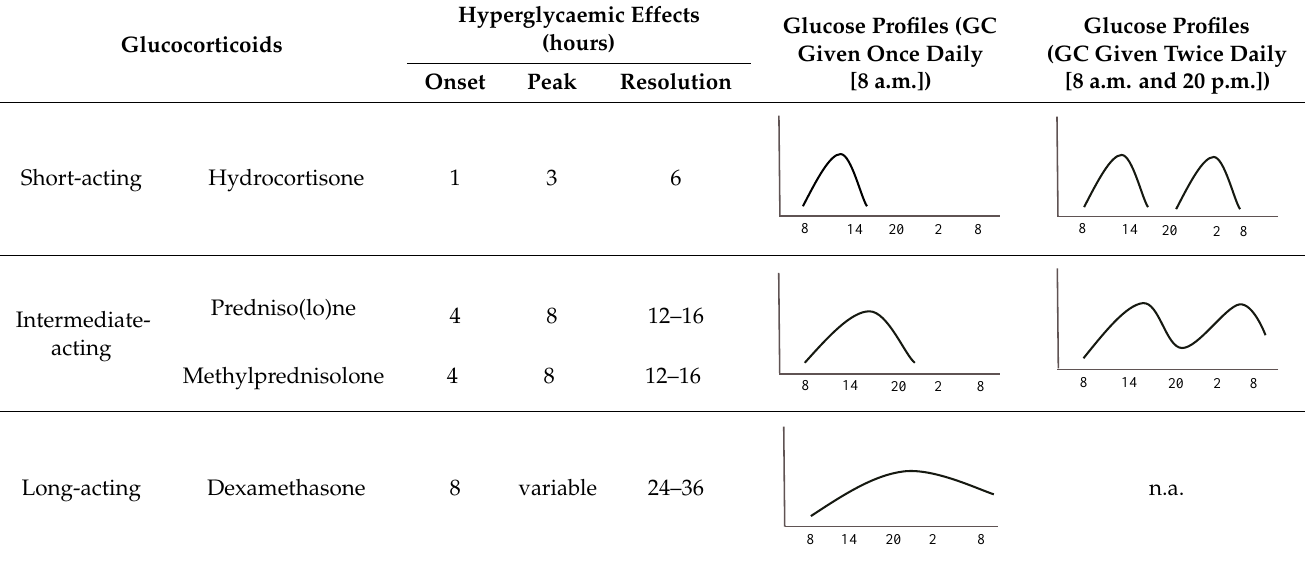
Table 2. Schematic illustration of different glucocorticoids and their potential effect on glycaemia. Long-acting agents are usually administered only once daily. These examples are presuming people with normal glucose homeostasis prior to start of glucocorticoid therapy. X-axis: time of the day; y-axis: potential influence on glucose.